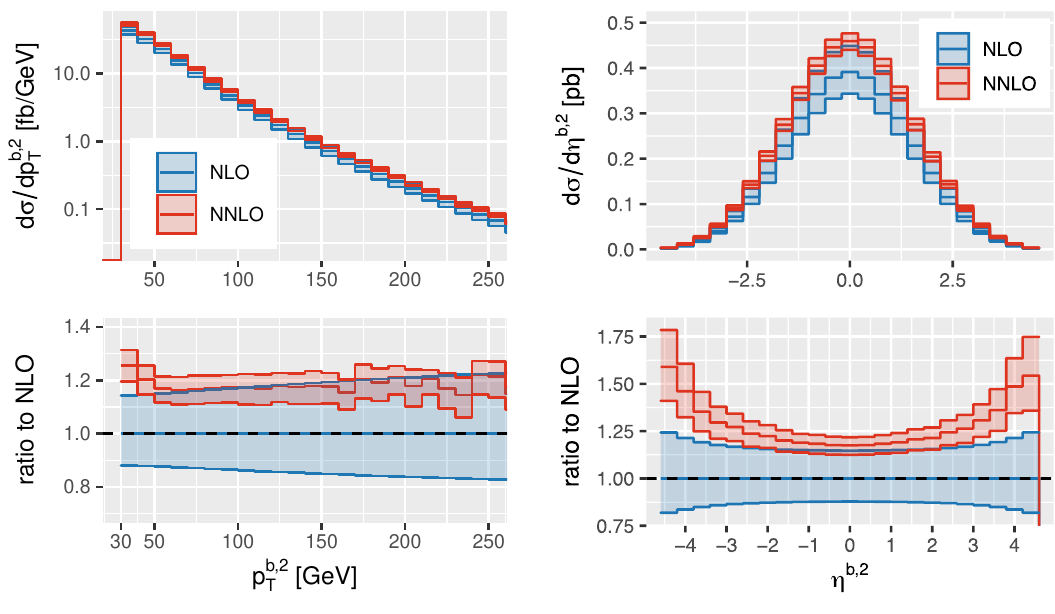
Figure 15 . p T -subleading b -tagged jet transverse momentum distribution (left) and pseudorapidity distribution